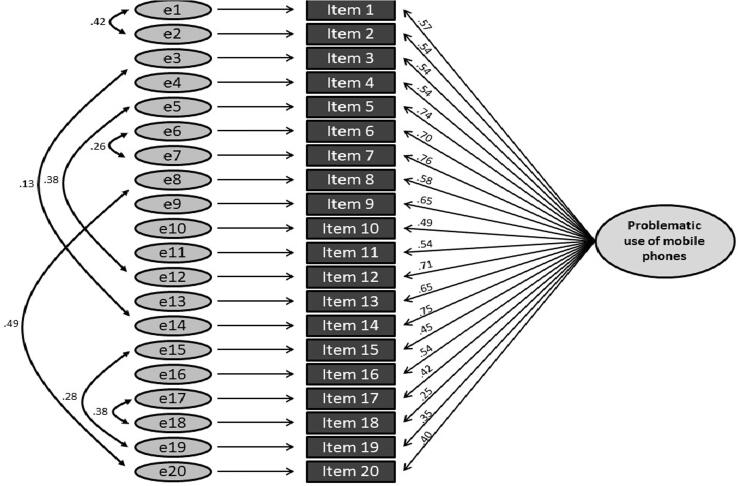
Path diagram for the confirmatory factor analysis of the PUMP-D for Model 3 with intercorrelated items, showing standardised path coefficients. All path coefficients are significant at p < .001.